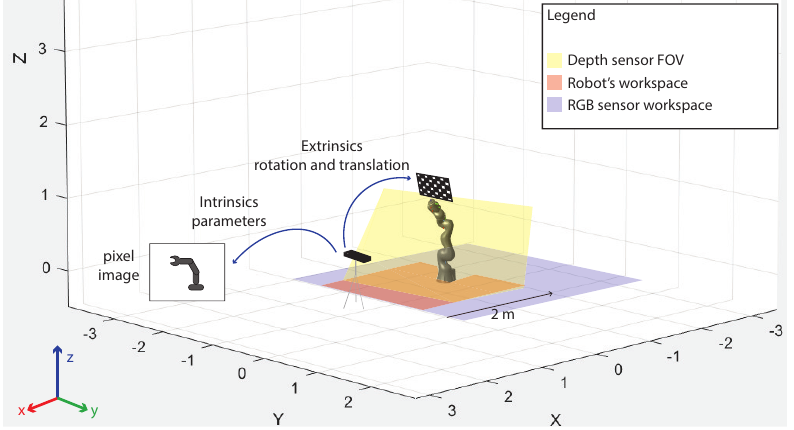
Figure 8. Schematic view of the calibration process with representation of sensor workspace and robot workspace. The axes measurement units are assumed in m.